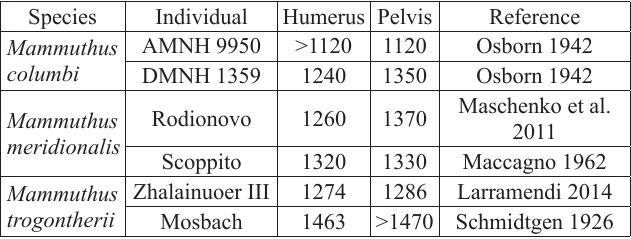
Table 11. Measurements (in mm) of maximal lengths of pelvic bones and humeri of different Mammuthus specimens; >,